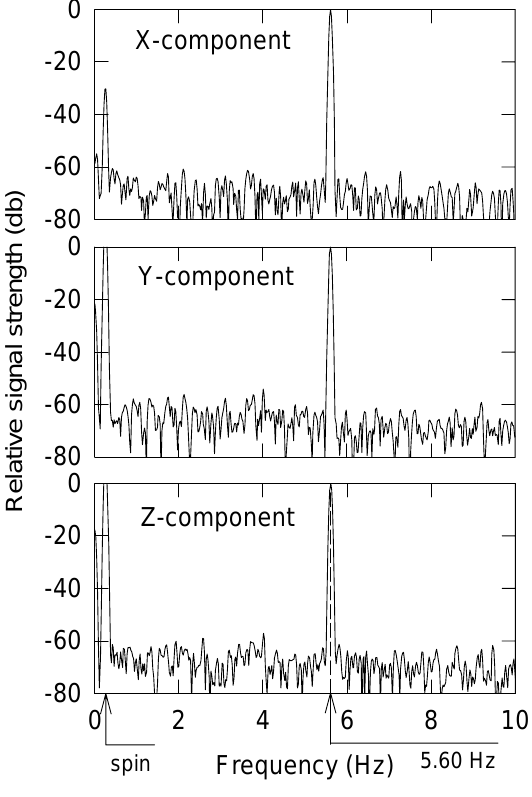
Fig. 5. Frequency domain analysis of the in-flight calibration se- quence shown in Fig. 4 for the three components of the magnetic field. The lower two panels show the spin plane components, the upper panel shows the nominally spin-aligned component. The signal-to-noise ratio of the calibration signal (at 5.90Hz) is more than 60db.